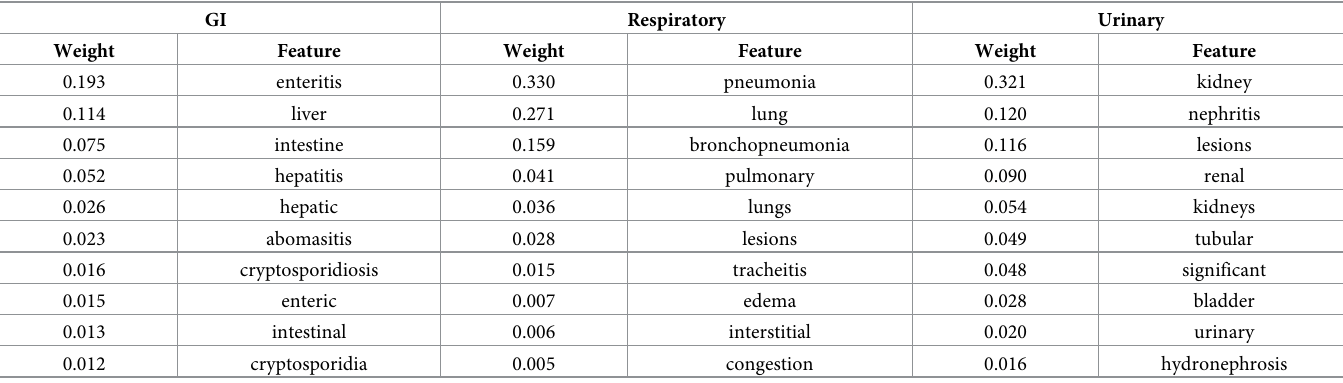
Table 4. Feature importance for random forest.